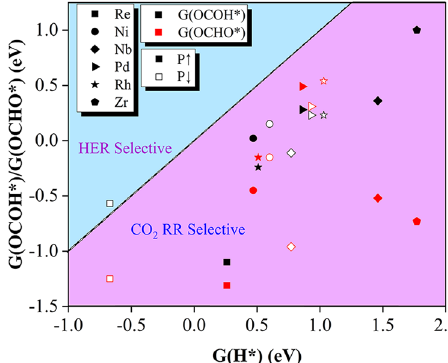
Fig. 3 Selectivity for CO 2 RR vs HER. Gibbs free energy changes ( Δ G) of initial protonation of CO 2 RR vs . HER on TM@In 2 Se 3 (TM = Ni, Pd, Rh, Zr, Nb and Re). Data points in the purple region denote higher selectivity toward CO 2 RR, while those in the blue region toward HER. Black and red symbols stand for Δ G(OCOH*) vs Δ G(H*) and Δ G(OCHO*) vs Δ G(H*),